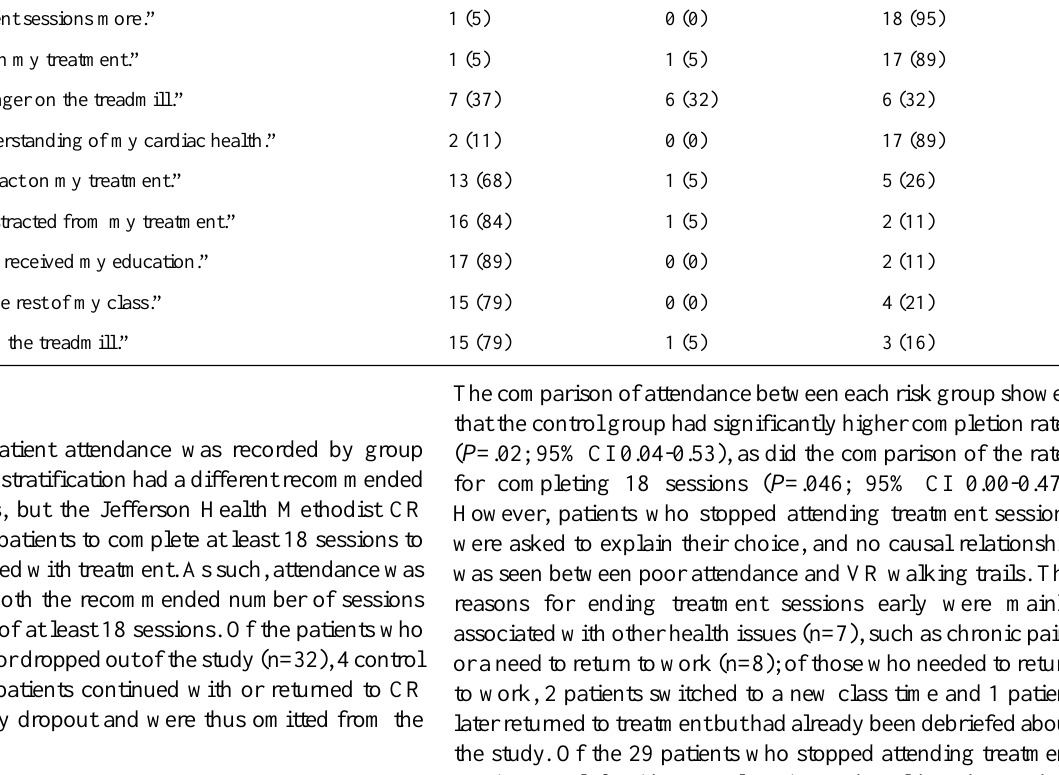
Table 5. Patient attendance by completion of minimum required sessions and by recommended number of sessions.